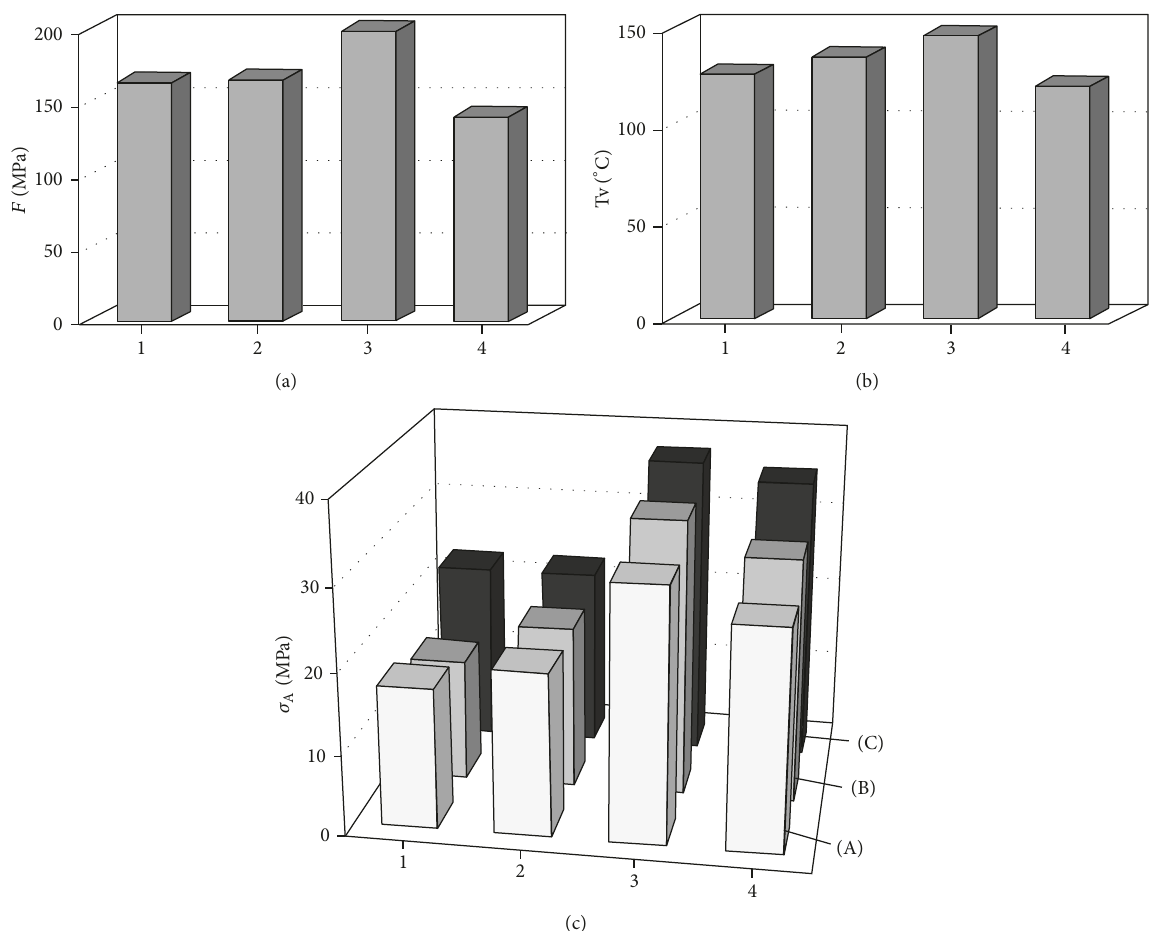
Figure 8: Surface hardness ( 1 ), Vicat softening temperature (b), and the strength of adhesive bonding ( c ) VV0 -PVP-gr-PMMA compositions depending on comonomer nature: 1, without comonomer; 2, VP; 3, GMA; 4, HEMA. Nature of support material: ( 0 ) steel/steel; ( j ) ceramics/ceramics; ( b ) steel/PMMA.